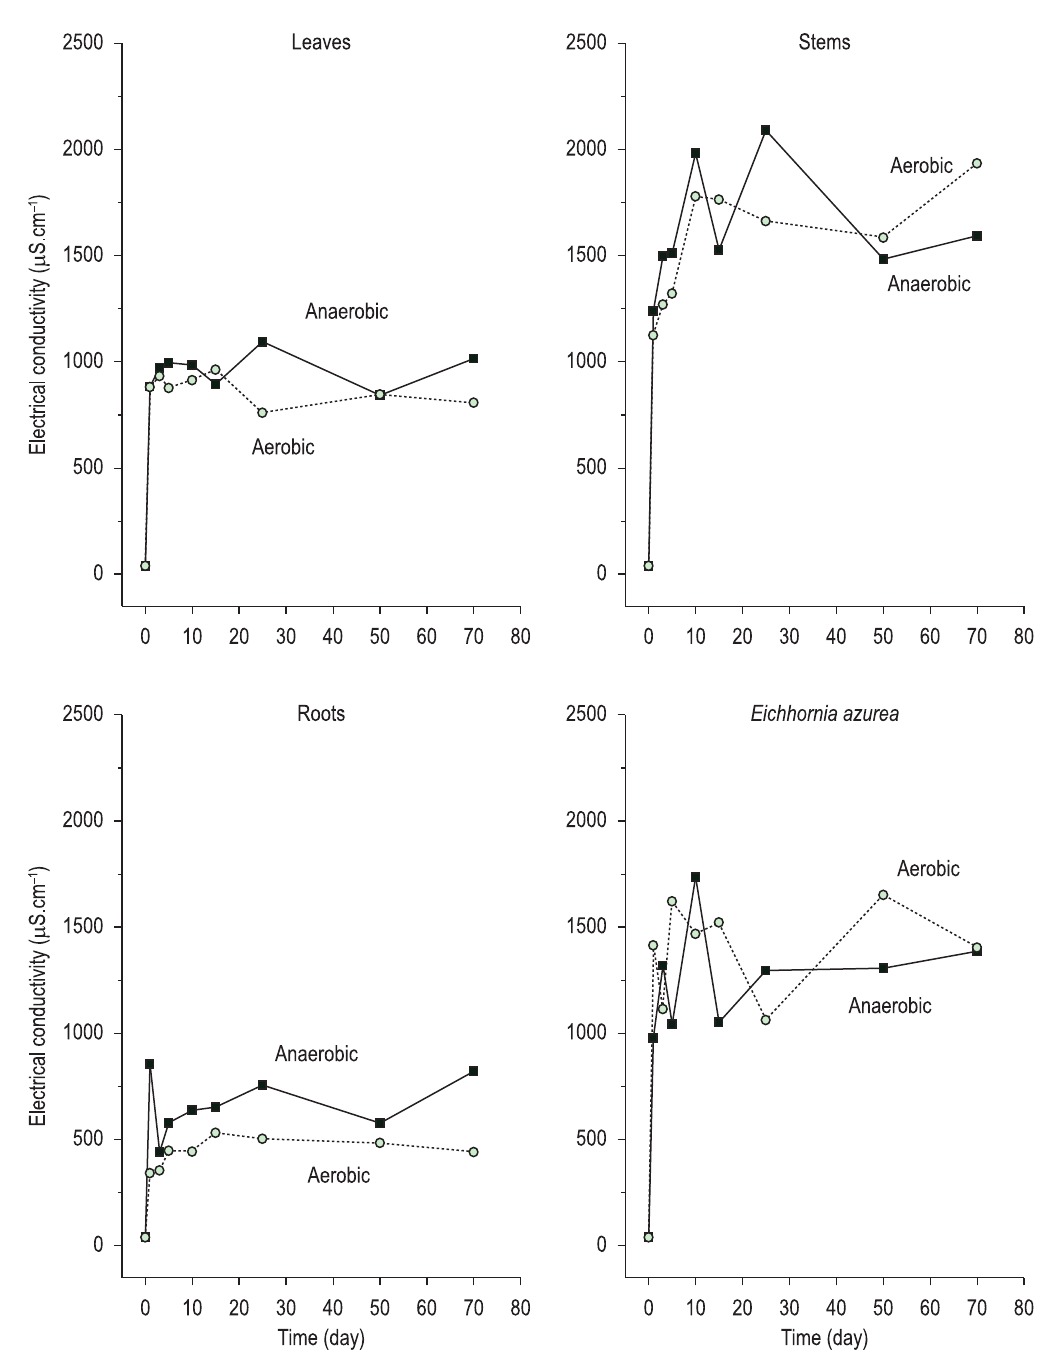
Figure 4. Temporal variations of electrical conductivity during the decomposition of leaves, stems, roots and Eichhornia azurea under aerobic and anaerobic